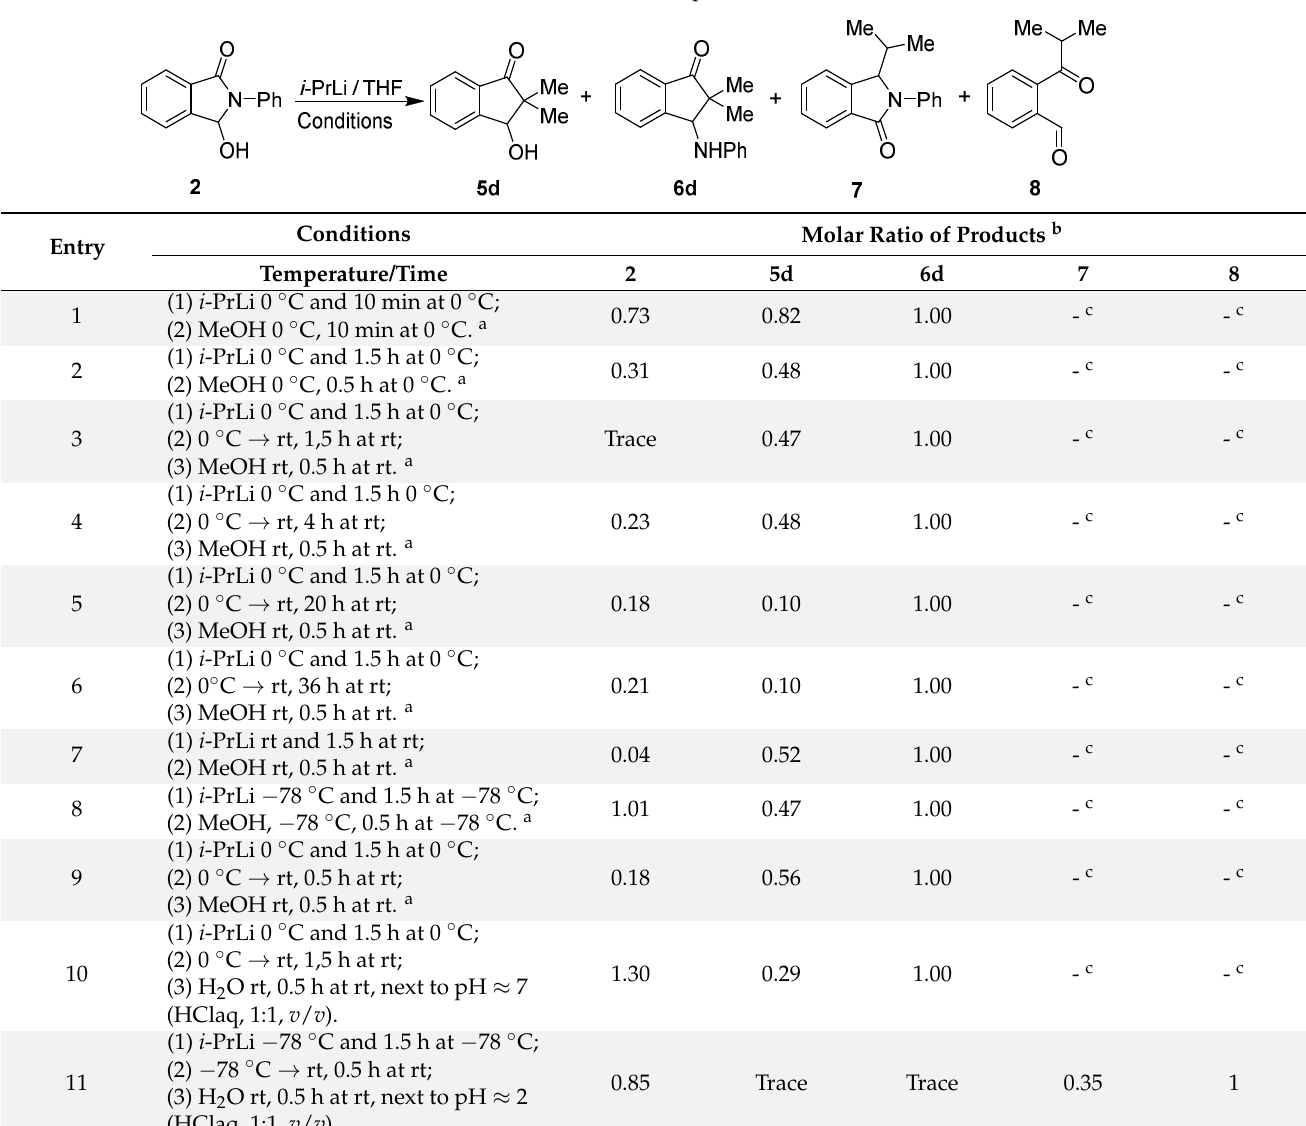
Table 1. Effect of reaction conditions on products’ distribution.